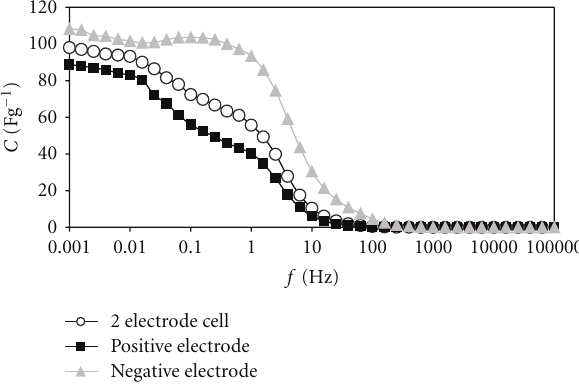
Figure 9: Capacitance versus frequency for a supercapacitor built from composite W3 in a two- and three-electrode